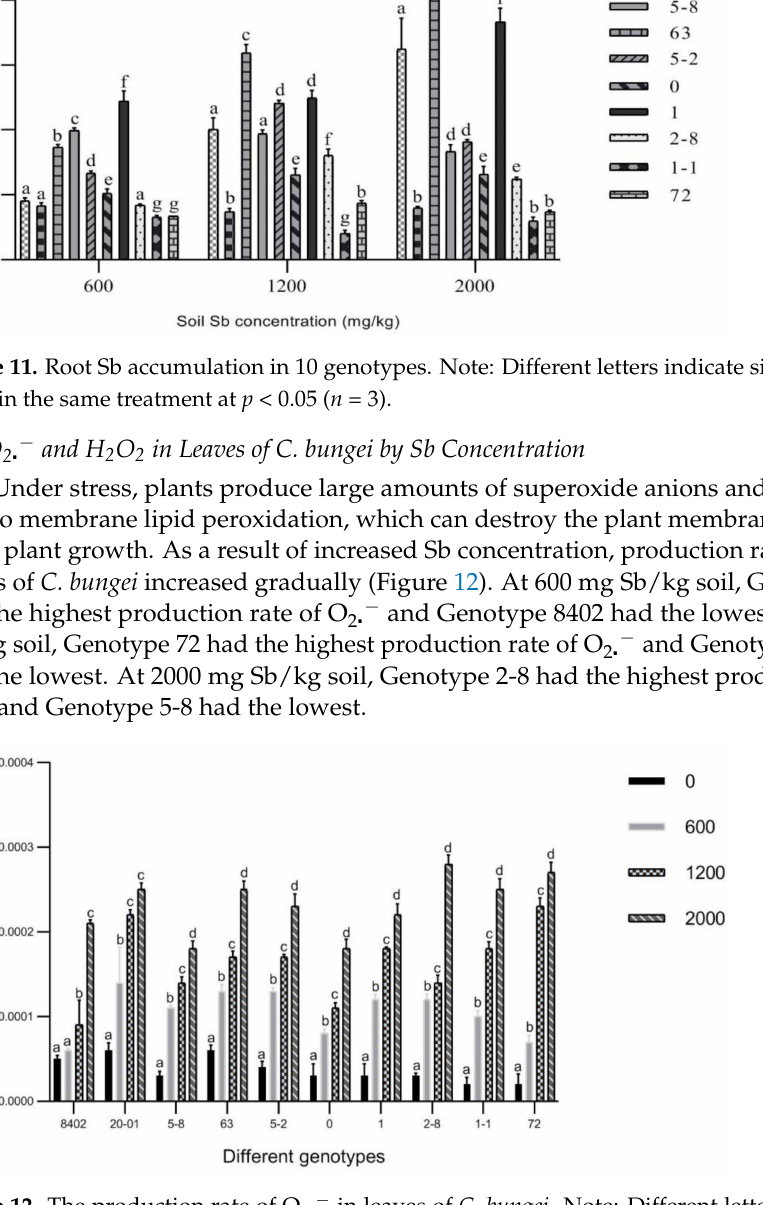
Figure 12. The production rate of O 2 (cid:5) − in leaves of C. bungei . Note: Different letters for the same genotype indicate significant differences among the treatments at p < 0.05 ( n = 3). The same below. At 600 mg Sb/kg soil, Genotype 5-8 had the highest production rate of H 2 O 2 in leaves, and Genotype 20-01 had the lowest. At 1200 mg Sb/kg soil, Genotype 20-01 had the highest production rate of H 2 O 2 , and Genotype 0 had the lowest. At 2000 mg Sb/kg soil, Genotype 20-01 again had the highest production rate of H 2 O 2 , and Genotype 5-8 had the lowest (Figure